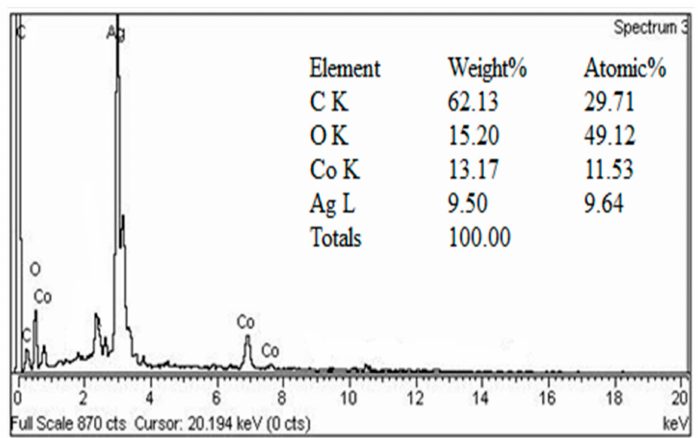
Figure 2. Energy dispersive X-ray spectrum of Ag-Co/S nanoparticles.